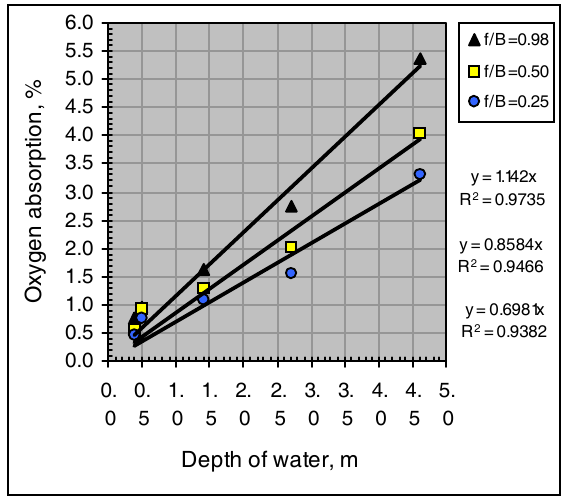
Figure 9: Effect level of depth of water (h) on oxygen absorption ( δ ) at constant air flow